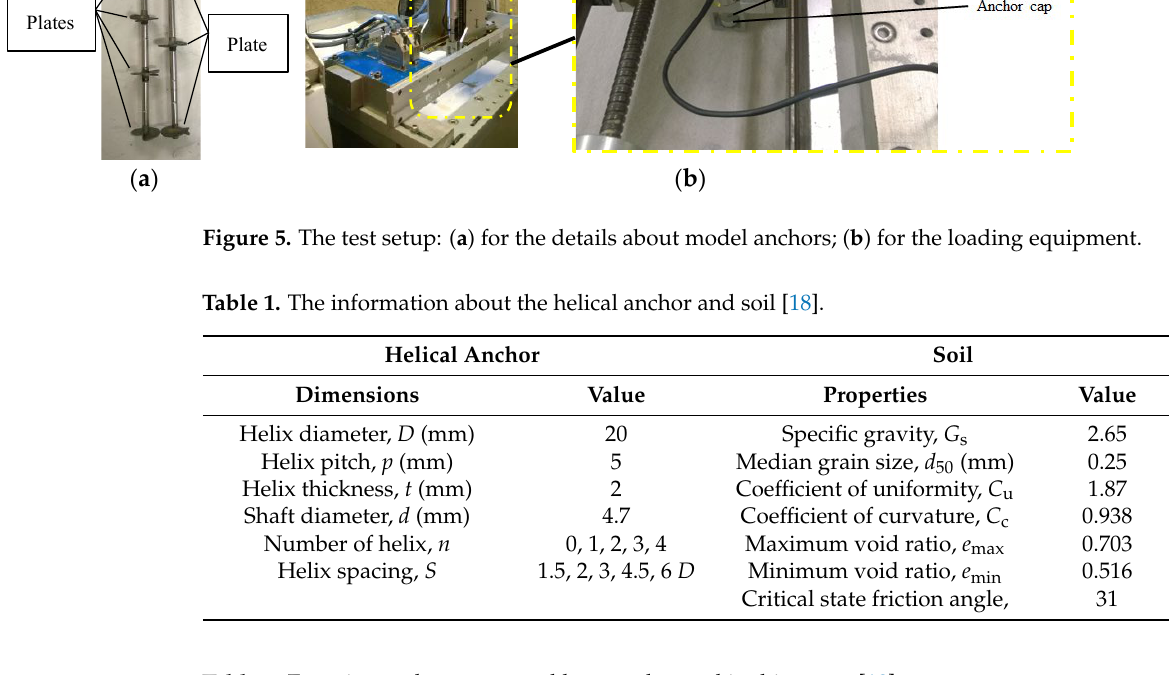
Table 2. Experimental program and key results used in this paper